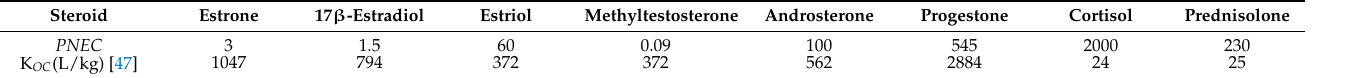
Table 2. PNEC values of target steroids (ng/L).